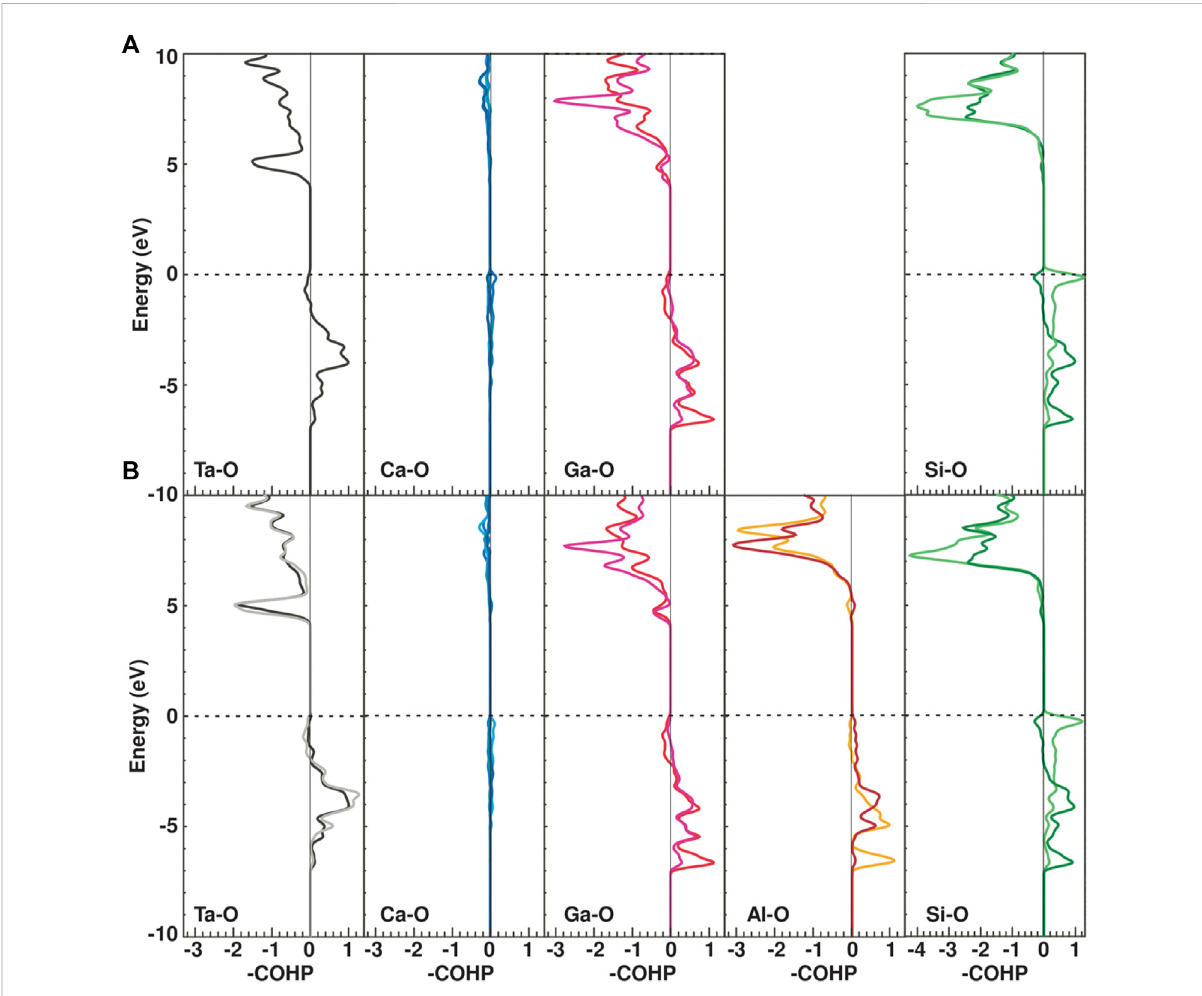
FIGURE 9 COHP per bond for Ta-O, Ca-O, Ga-O, Al-O, and Si-O bonds in CTGS (A) and CTGAS (B) crystals. The E F was indicated by horizontal broken lines and was set to zero on the vertical